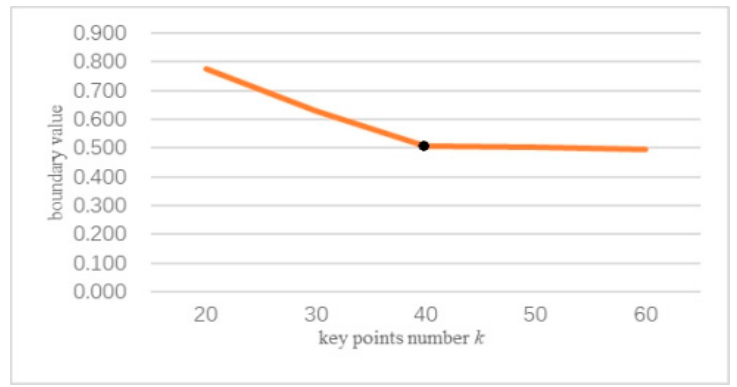
Figure 10. The boundary values with the number of key points k .